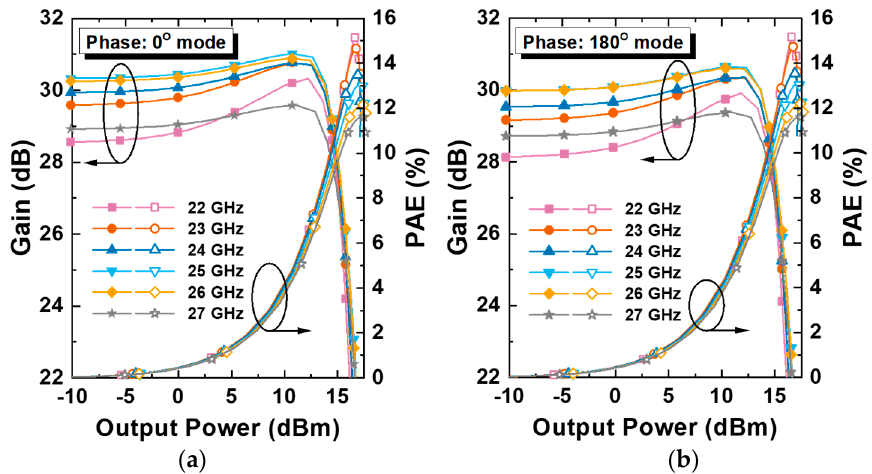
Figure 9. Simulation results: gain and PAE according to the output power: ( a ) 0°- and ( b ) 180°- modes.